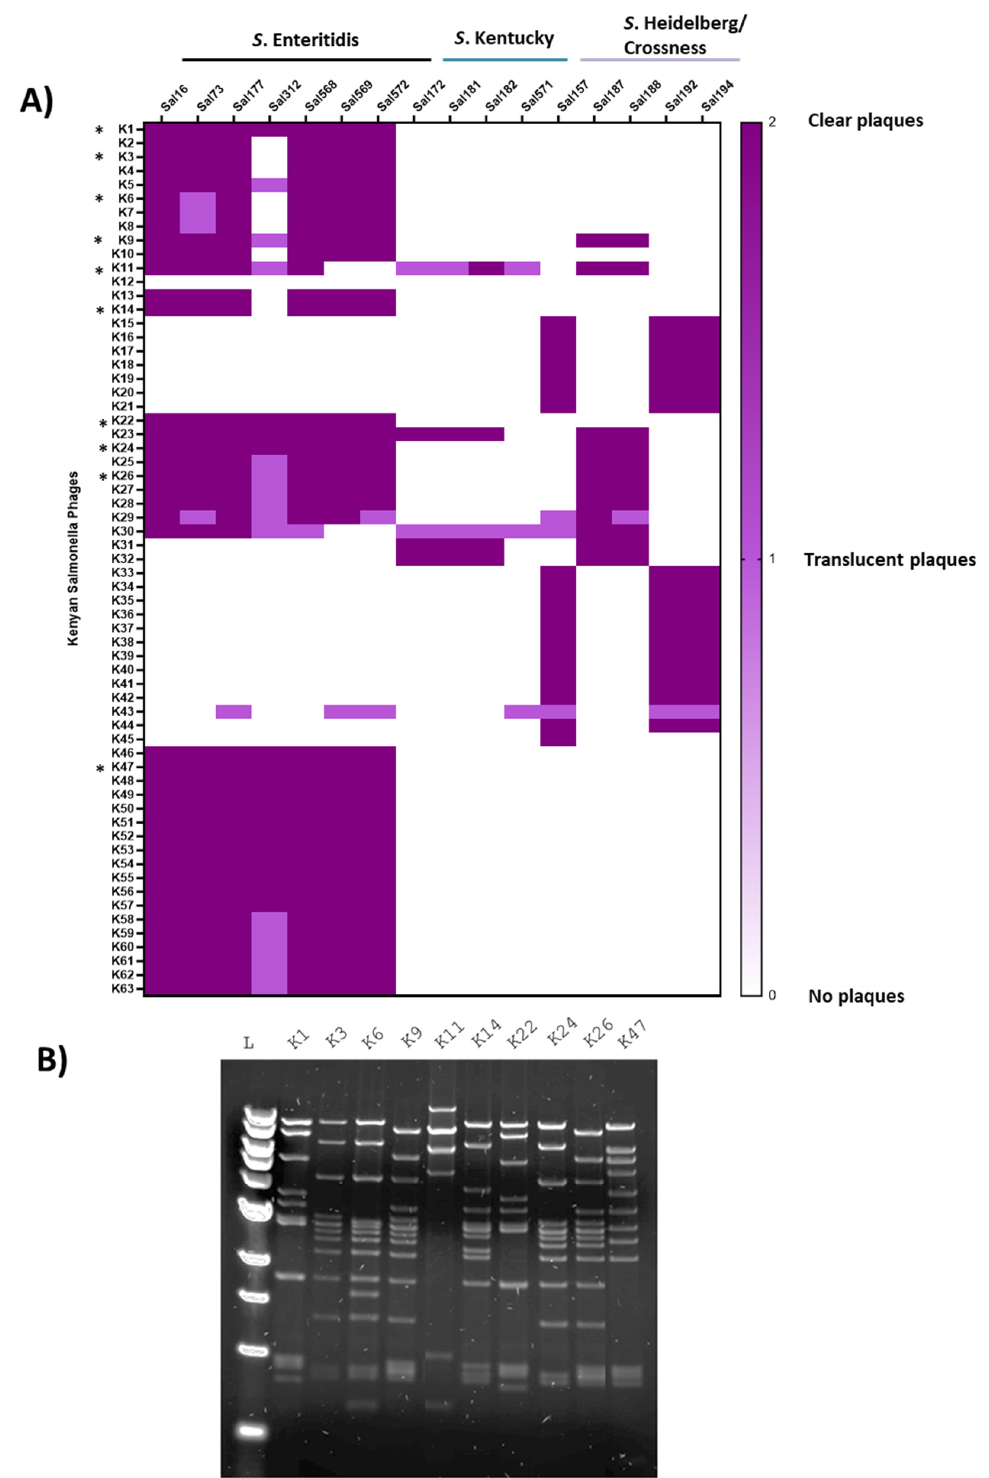
Figure 1. Salmonella phage host range and restriction fragment length polymorphism (RFLP) of their genomic DNA. ( A ) A heatmap showing a set of 63 isolated Salmonella sp. phages and their tropism for the Enteritidis, Kentucky, and Heidelberg serovars. Dark purple colour indicates clear plaques, violet colour indicates translucent plaques, and white stands for no plaques. The asterisk ( * ) indicates the selected phages. ( B ) Gel electrophoresis of the DNA digested with EcoRV from the genomes of Kenyan S . Enteritidis phages revealing 10 DNA profiles.